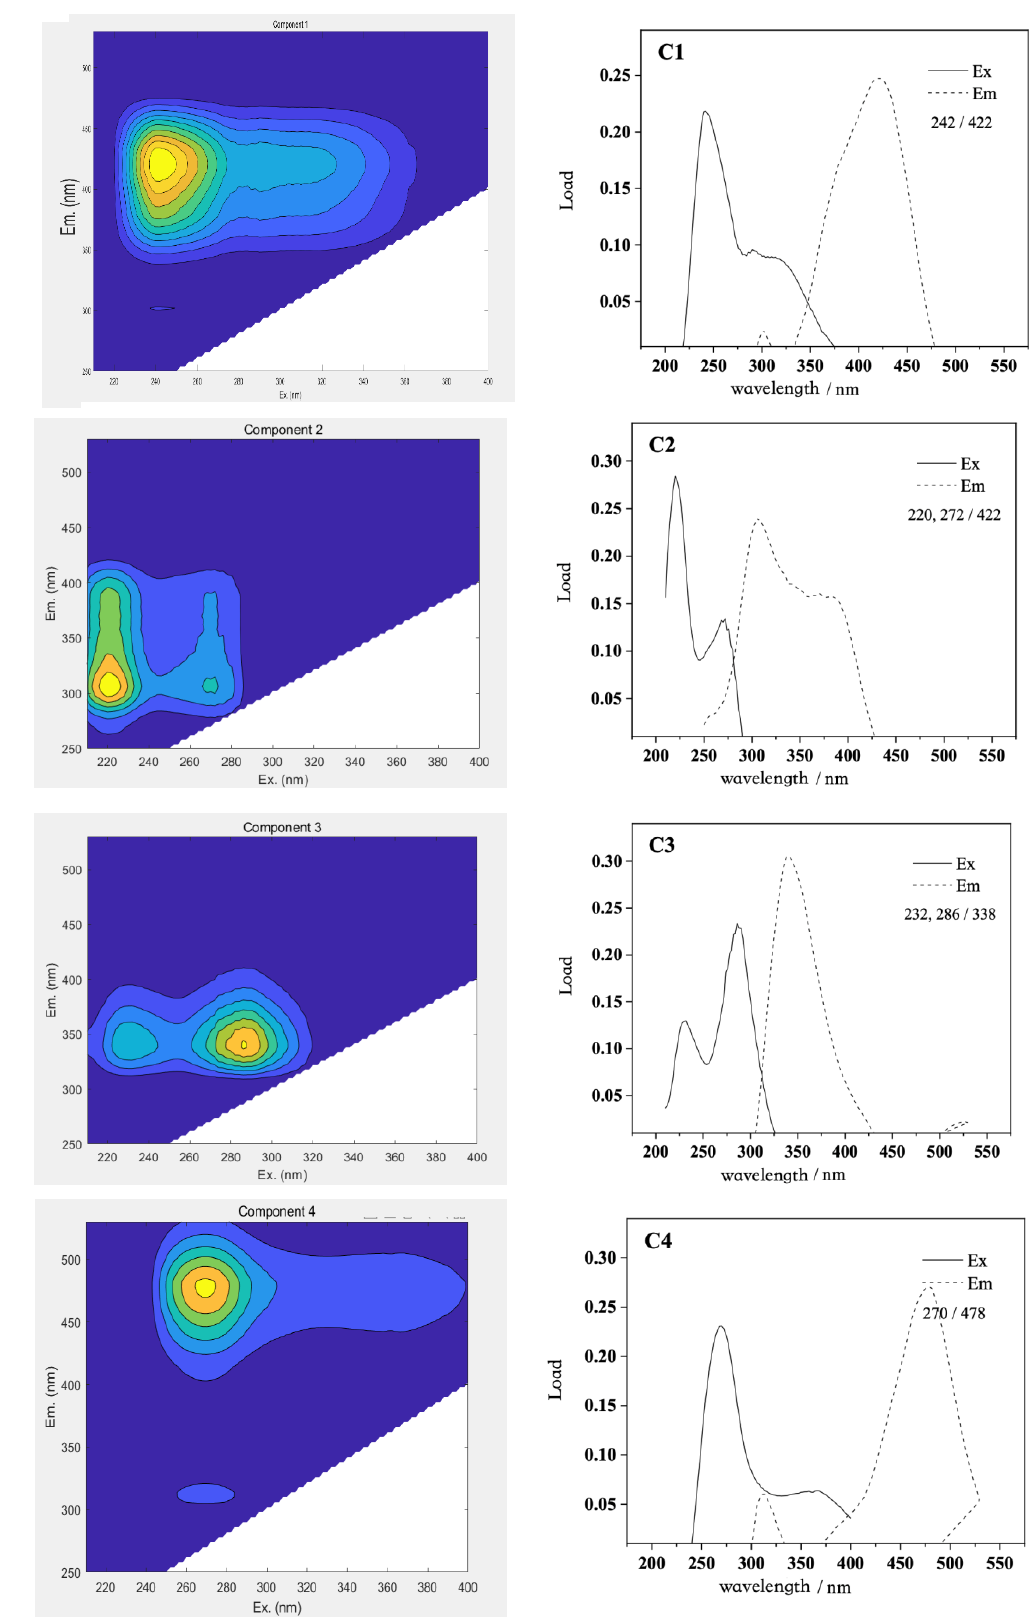
Figure 12. Characteristics of the fluorescent components of DOM in Qinghai Lake. The excitation wavelength of component C1 was at 242 nm, and the maximum emission wavelength was near 422 nm, which reflected the land-based high-molecular- weight humic acid, which was mainly from the degradation of higher plants or soil leaching. Component C2 had two obvious excitation wavelengths at 220 and 272 nm, and the maximum emission wavelength was 422 nm, which reflected the fluorescence peak of low-molecular-weight fulvic acid, which mainly came from the fluorescence peak formed by biodegradable organic compounds. Component C3 had two obvious excitation wavelengths at 232 and 286 nm, and the maximum emission wavelength was 338 nm. It had binding peaks similar to those of protein and fulvic acid, which have a red shift compared with the conventional tryptophan-like peak. Component C4 had an obvious